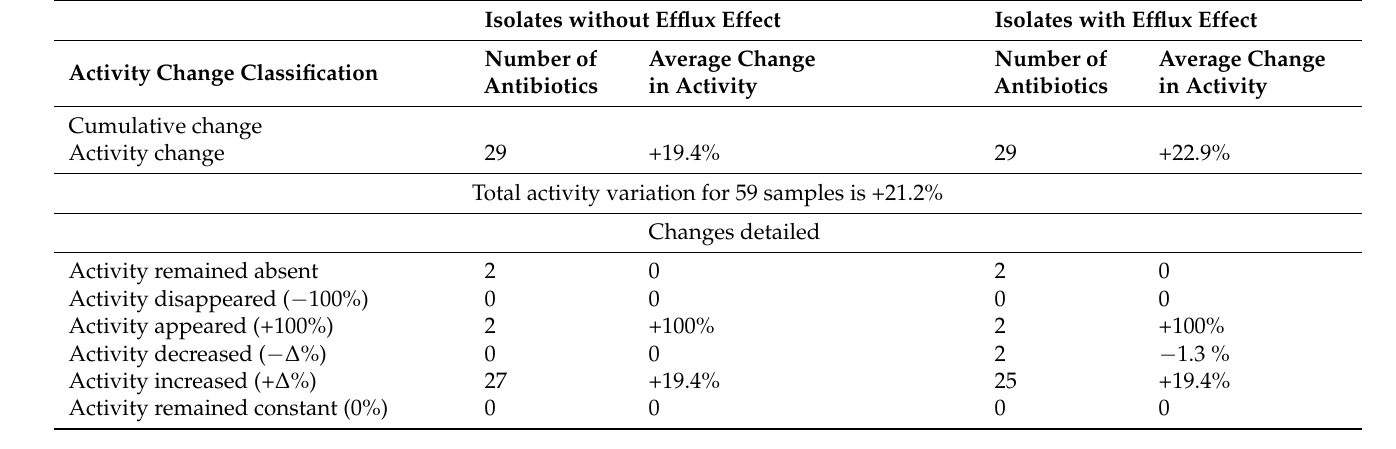
Table 4. Change in E. coli susceptibility to antibiotics (for isolates with and without efflux effect) caused by Argovit-C TM